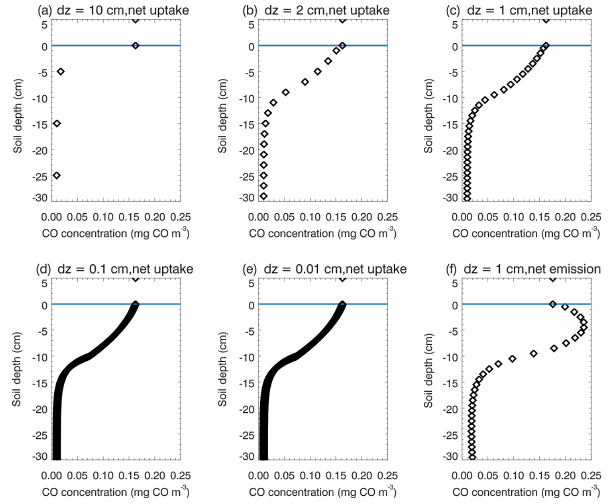
Figure 12. Daily mean vertical soil CO concentration profiles of the top 30cm. In the soil (depth < 0cm), black diamonds repre- sent the soil CO concentration (mgCOm − 3 ) . Above the surface (depth > = 0cm), black diamonds represent the atmospheric CO concentration. (a) , (b) , (c) , (d) and (e) are the results from the same day when soils are a net sink of CO, but using different layer thick- nesses (d z = 10, 2, 1, 0.1 and 0.01cm, respectively); (f) is the result from the day when soils are a net source of CO, with d z =